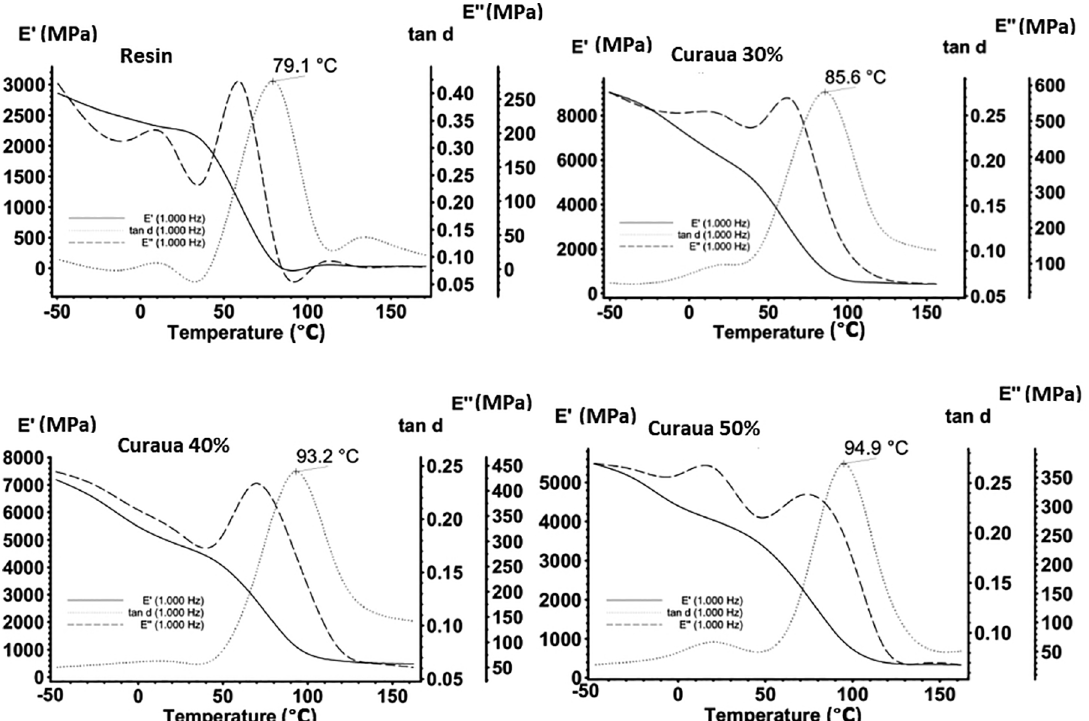
Figure 5. DMA test results of Curaua/Epoxy composites at 1